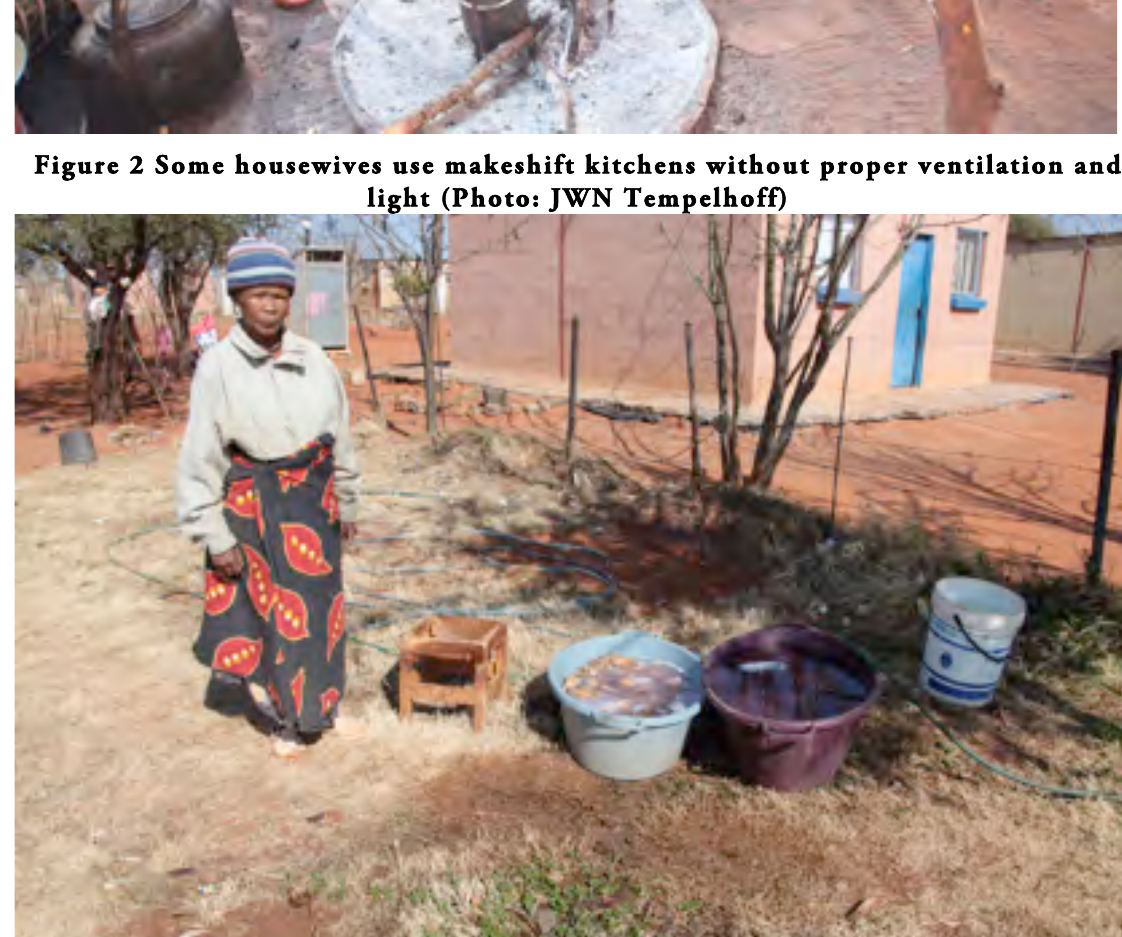
Figure 3 A senior member of the Platfontein community prepares to do the laundry. (Photograph: JWN